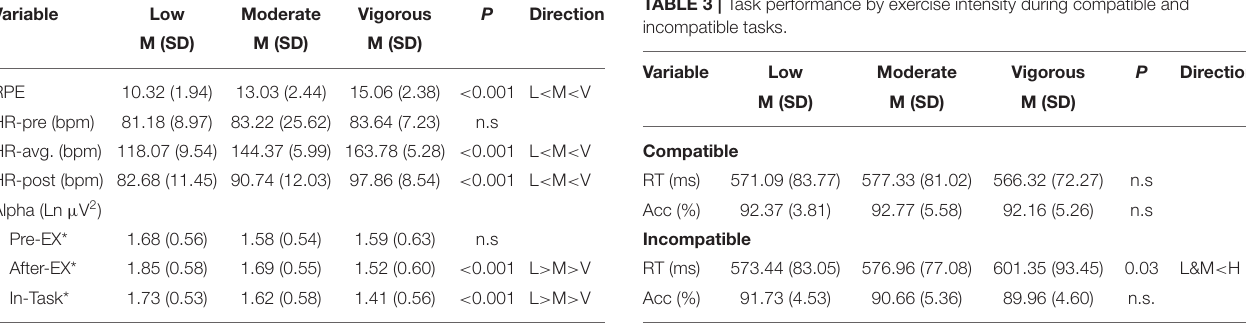
TABLE 2 | Descriptive data for exercise manipulation check and arousal level. Variable